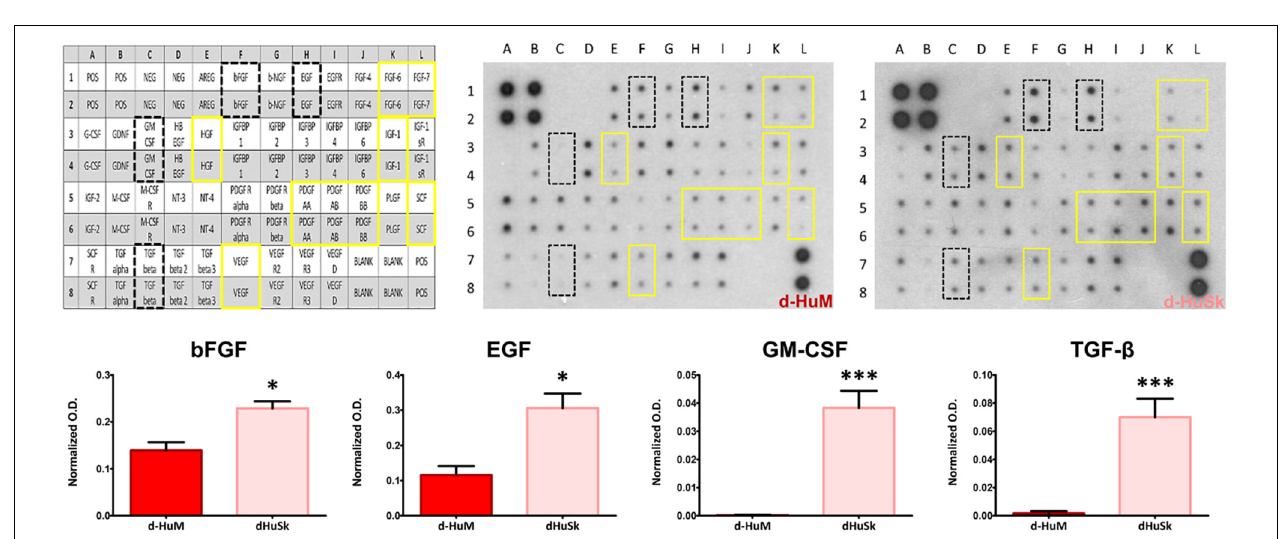
FIGURE 4 | Immunodetection of collagenous and non-collagenous ECM proteins in d-HuSk. Representative images of the immunohistochemical analysis showing the presence and localization in d-HuSk of type I (A) , type III (B) , and type IV (C) collagen, and of fibronectin (D) , laminin (E) , and tenascin (F) . Scale bar is 50 µ m.